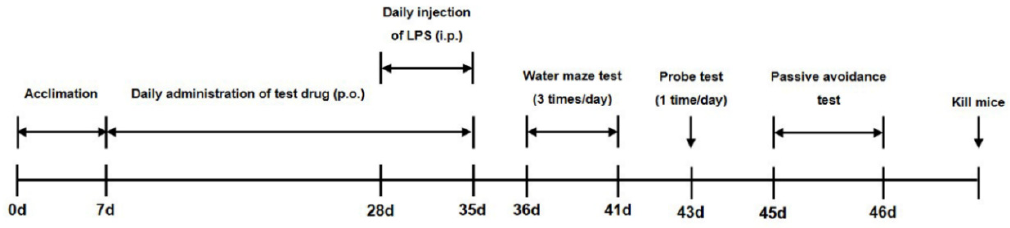
Figure 1. Overall experimental timeline for assessment of the effect of banhasasim-tang (BHS) on the cognitive function of mice with lipopolysaccharide-induced neuroinflammation. ICR mice were acclimated to the facility for 7 days (0–7 days), and the test drug BHS was administered by mouth (p.o.) for 4 weeks (7–35 days). During the final week, lipopolysaccharide (LPS; experimental groups) or PBS (control groups) was given intraperitoneally (i.p.). Between days 36 and 46, neurocognitive testing was held to collect endpoints. Mice were euthanized after completion of all testing.